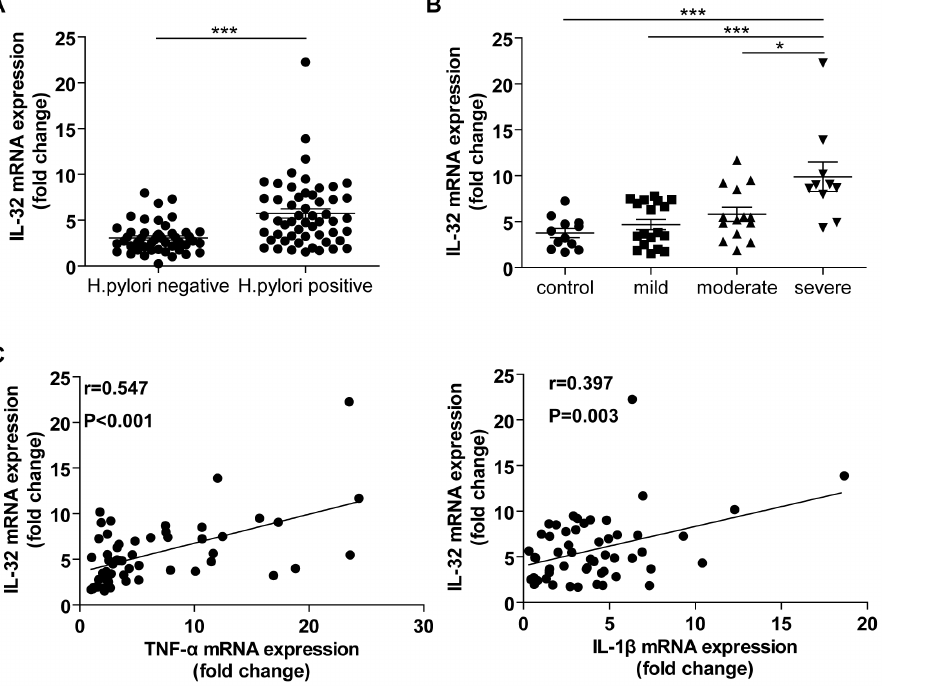
Figure 1. Gastric IL-32 mRNA in patients with H.pylori infection correlated with inflammation and inflammatory cytokine gene expression. A. IL-32 mRNA expression was detected by real-time PCR in gastric mucosa tissues from 54 H. pylori -positive patients and 47 H. pylori - negative healthy individuals; B. Analysis of the relationship between IL-32 mRNA levels and the degree of gastric inflammation in H. pylori -positive patients; C. IL-32 mRNA showed a positively correlation with those of TNF- a and IL-1 b . * P , 0.05; *** P ,